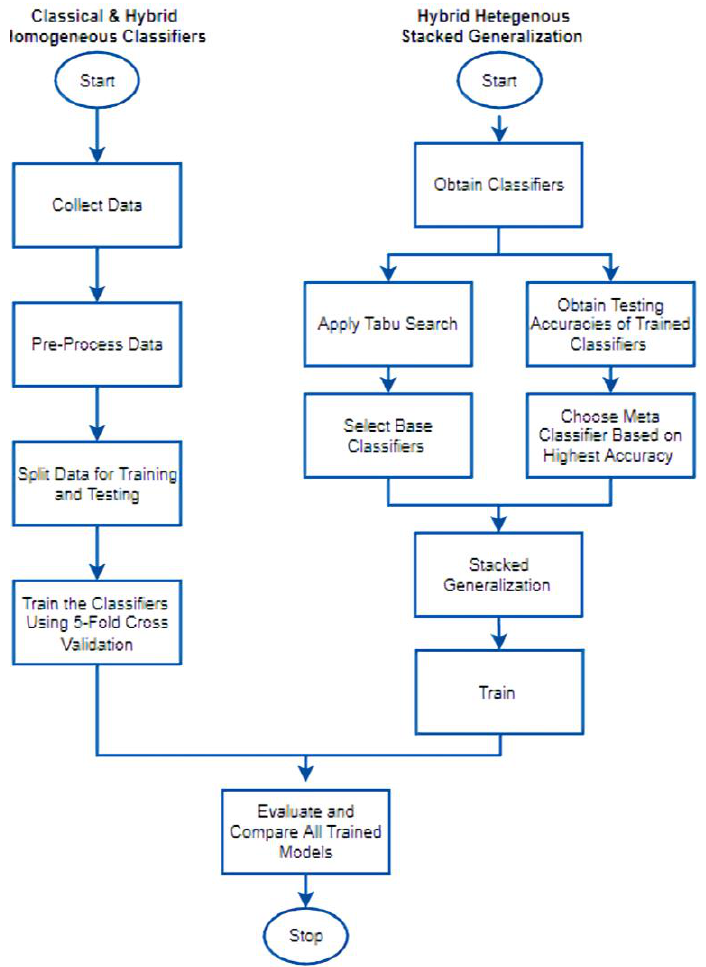
Figure 4. Flowchart of the research